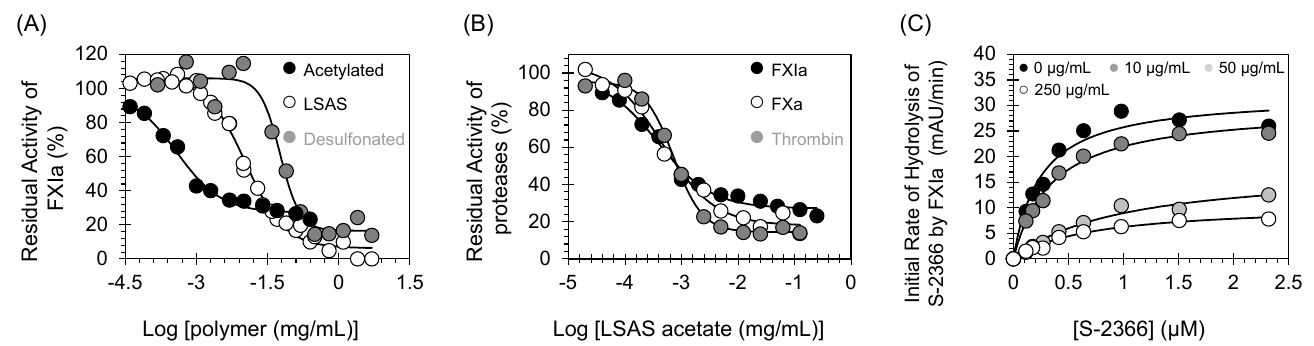
Figure 9. ( A ) Direct inhibition of FXIa by LSAS and its acetylated and desulfonated derivatives. The inhibition of FXIa by acetylated LSAS ( ● ), LSAS ( ○ ), and desulfonated LSAS ( ● ) was studied at 37 °C and pH 7.4. Solid lines represent sigmoidal dose–response fits using Equation (1) to the data to calculate the inhibition parameters. ( B ) Direct inhibition of coagulation serine proteases (thrombin ( ● ), FXa ( ○ ), and FXIa ( ● )) by acetylated LSAS. ( C ) Michaelis–Menten kinetics of S ‐ 2366 chromogenic tripeptide hydrolysis by FXIa in the presence of desulfonated LSAS. The initial rate of hydrolysis at different substrate concentrations was determined using wild ‐ type full ‐ length FXIa, in pH 7.4 buffer. The concentrations of desulfonated LSAS chosen in the study were 0 ( ● ), 10 ( ● ), 50 ( ● ), and 250 μ g/mL ( ○ ). Solid lines represent nonlinear regression fits to the data by the Michaelis–Menten Equation (3). Table 5. Inhibition profile of different polymers a .